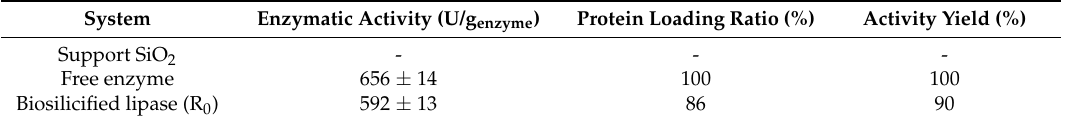
Table 1. Enzymatic activity, protein loading and activity yield of the analysed